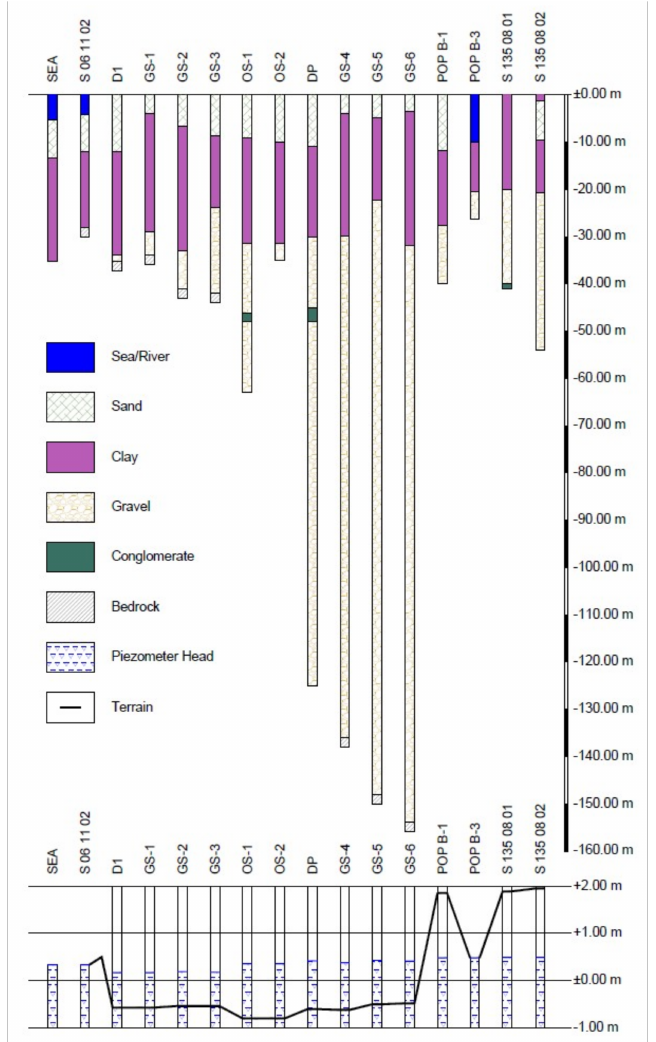
Figure 2. Schematic overview of available geological data and piezometric states in the area of interest (locations identified in Figure